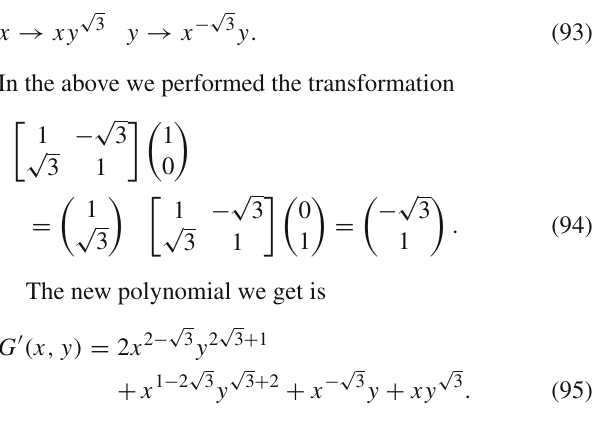
boundary subset of the Newton polytope S 1 mal vector n we